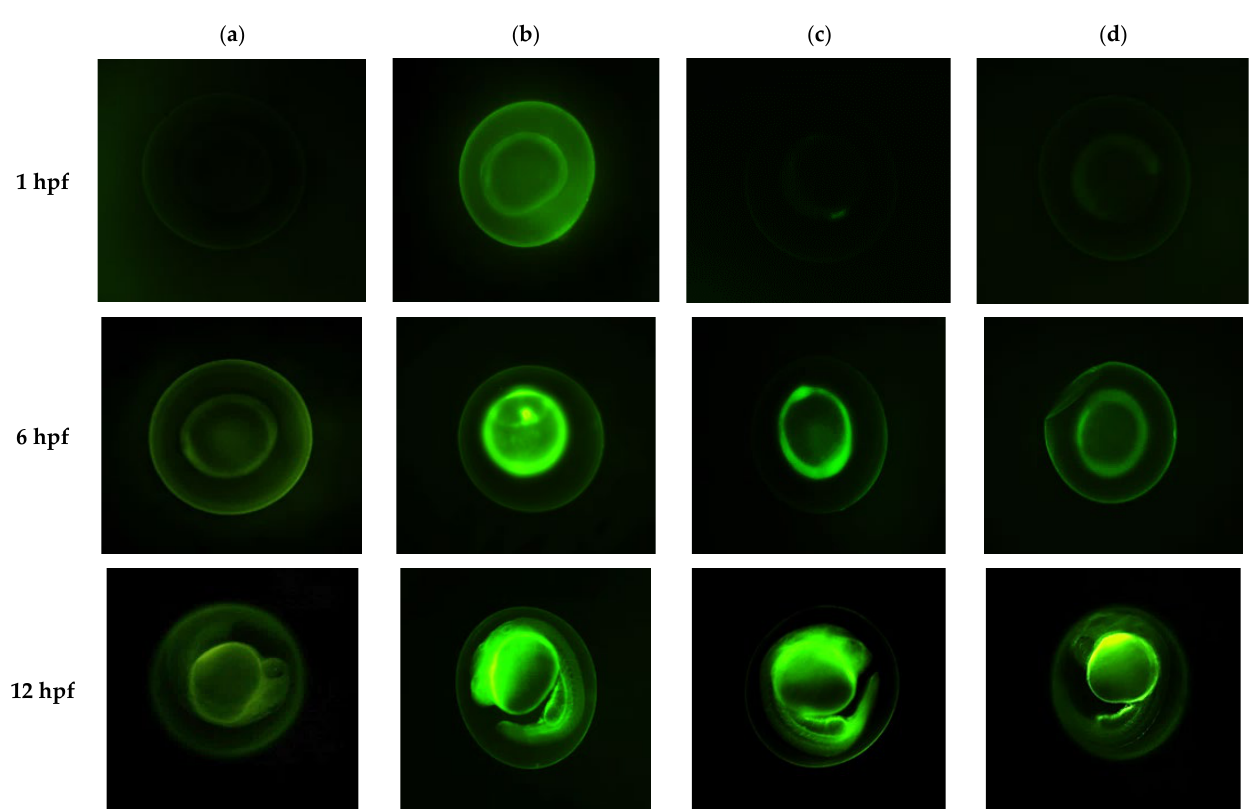
Figure 5. Fluorescence images of zebrafish ( Danio rerio ) embryos at the age of 1, 6, and 24 hpf (with chorion) after exposed to ( a ) 50 μg/mL fluorescein solution (control) and different sizes of nanoemulsions ( b ) NE 100, ( c ) NE 150, and ( d ) NE 200 containing 50 μg/mL fluorescein. The incubation was conducted at 28 ± 1 °C and the embryos were observed under an inverted fluorescence microscope and captured using CFI Plan Fluor 10× objective. Hpf: Hours post-fertilization, NE: Nanoemulsion.